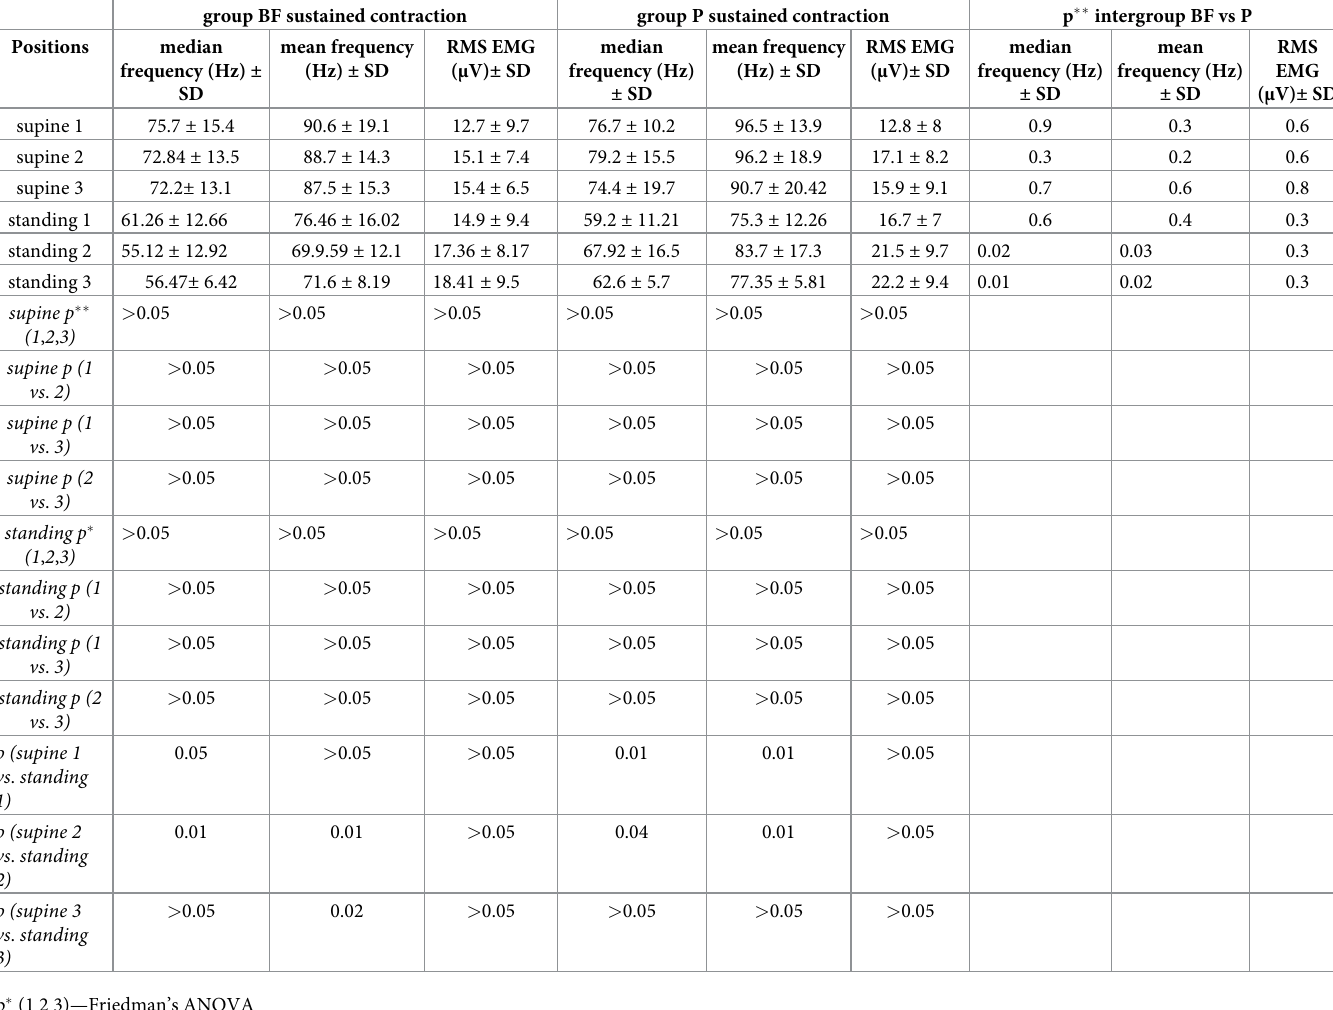
Table 3. Intra- and intergroup analysis of sEMG amplitude of the sustained 60-second contraction of the pelvic floor muscles. group BF sustained